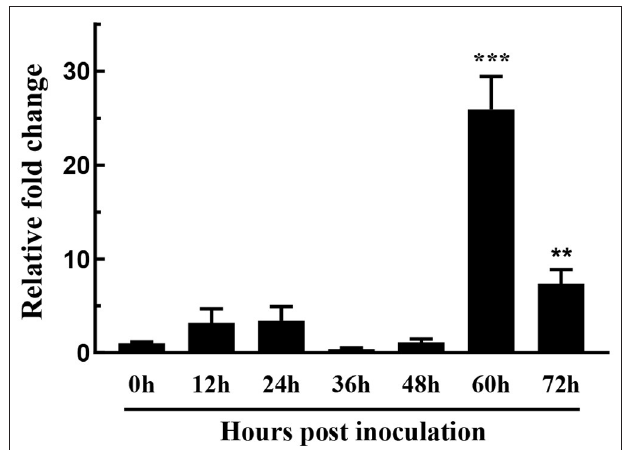
FIGURE 2 | The expression level of FoSSP1 in Foc4 WT during different times after being inoculated in banana roots (0, 12, 24, 36, 48, 60, and 72 hpi). The relative expression of FoSSP1 in conidia (0h control) was arbitrarily set to 1. The results are representative of three independent experiments. Error